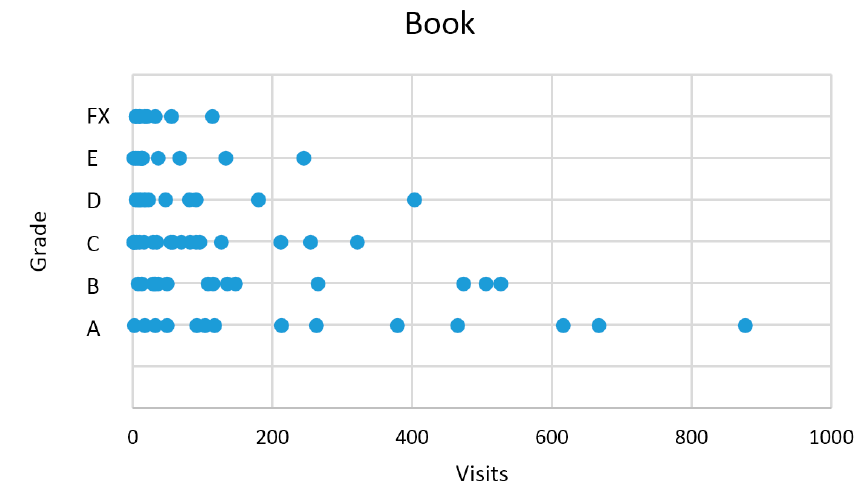
Figure 8. Grades based on visits in “Book” material.